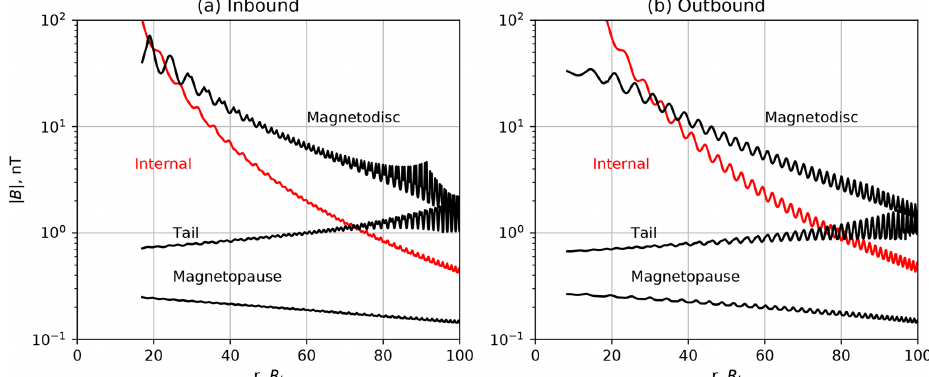
Figure 4. As for Fig. 3, but for perijove